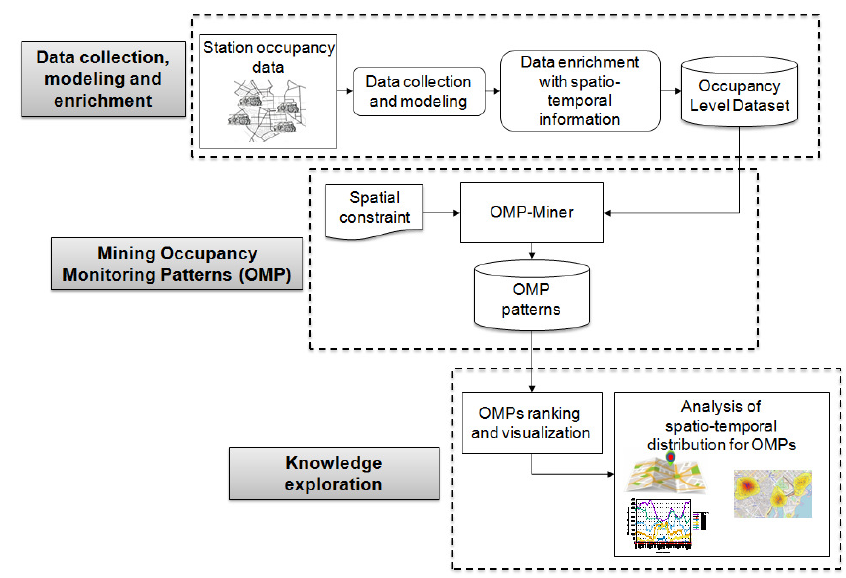
Figure 1. The B ike Station Ov E r L oad Ana L yzer (BELL)